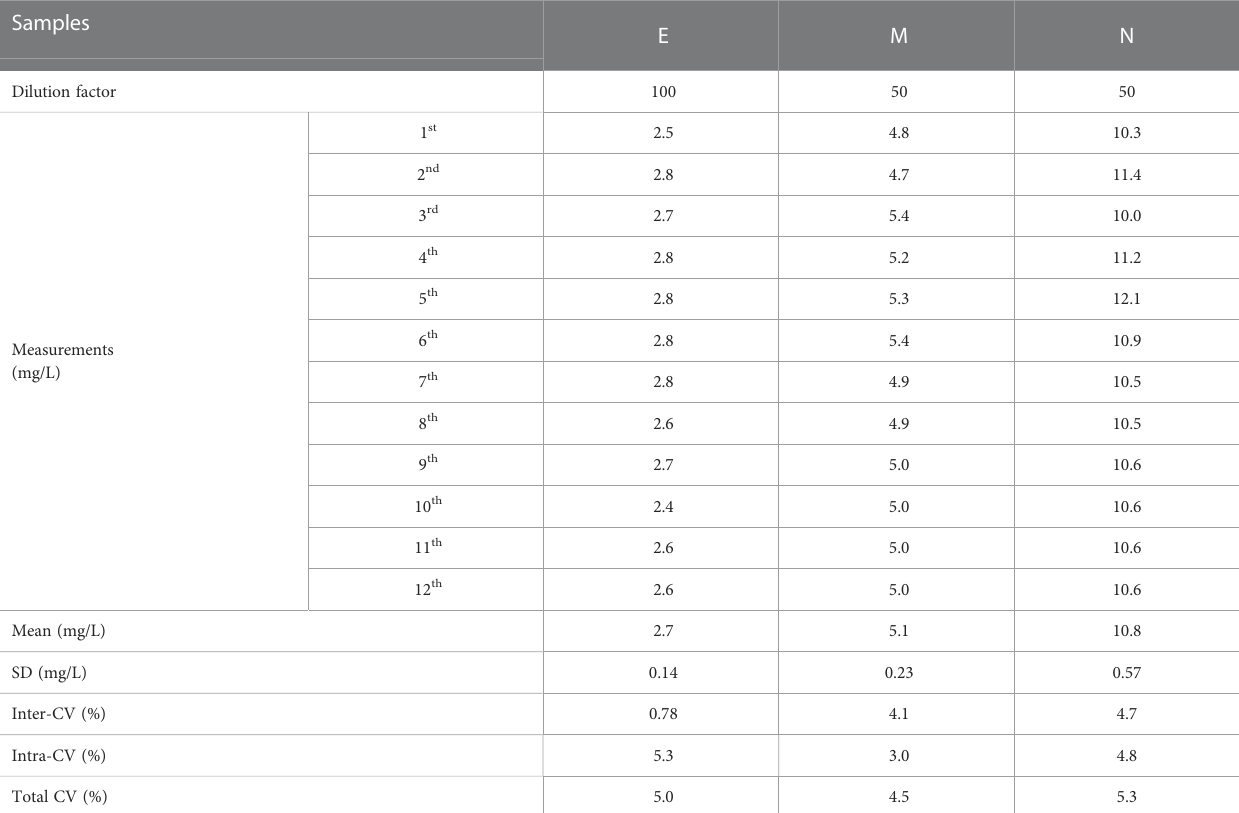
TABLE 2 Iodine concentration of the three iodine-containing soy sauces. Samples